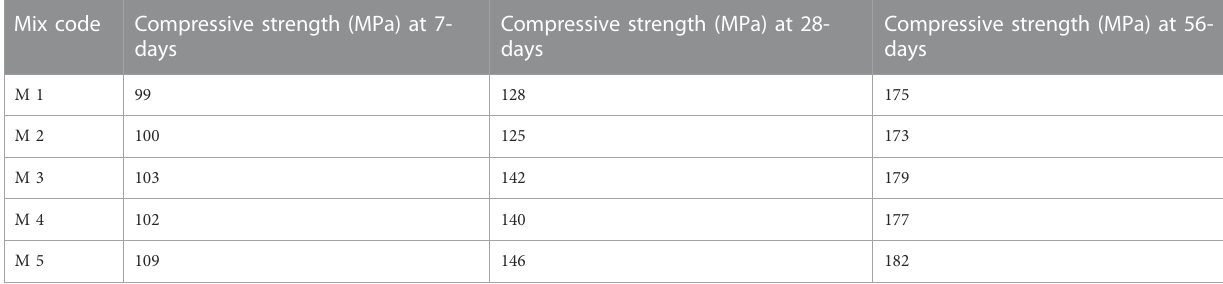
TABLE 7 Results of the compressive strength